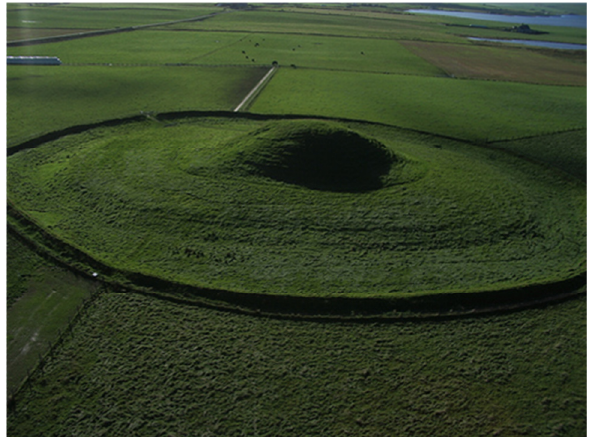
Figure 8. Maeshowe chambered tomb, as seen from the air © Crown Copyright 2008.